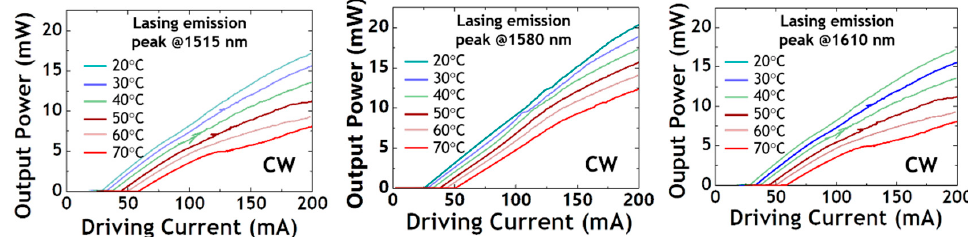
Figure 11. LIV Characteristics measured under CW regime up to 70 °C for the lasers emitting at 1515, 1580 and 1610 nm.